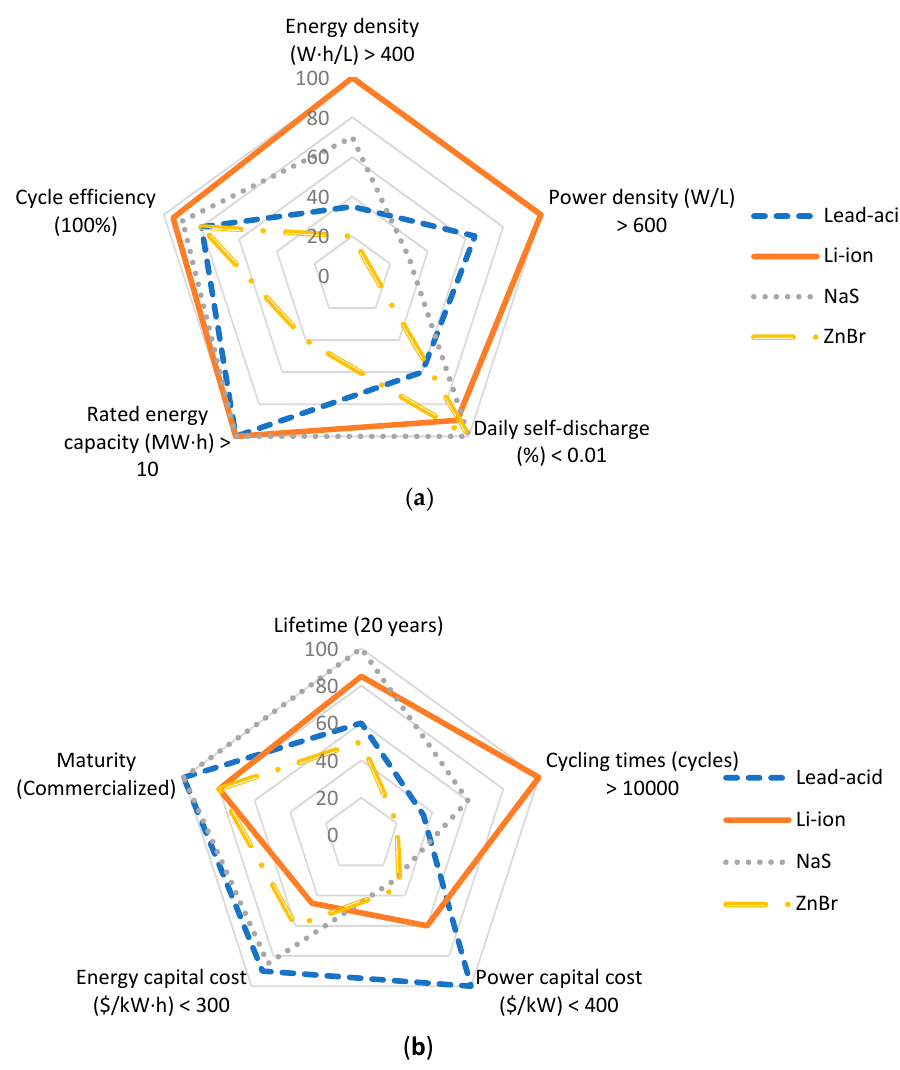
Figure 1. Characteristics of different batteries. ( a ) Technical characteristics; and ( b ) Economic and lifetime characteristics.